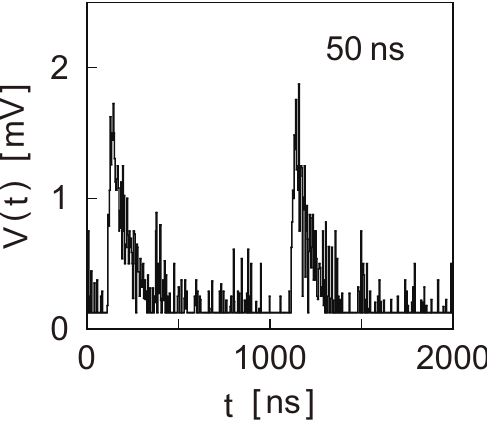
Figure 5. Output pulses from a single-atom contact of Cu when rectangular pulses of 50 ns wide were injected. Because of a large stray capacitance, the pulse shape is heavily distorted from its rectangular waveform. Reproduced from [57], copyright (2010) The Japan Society of Applied